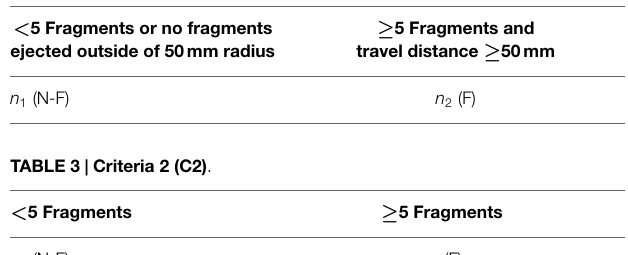
TABLE 2 | Criteria 1 (C1) .